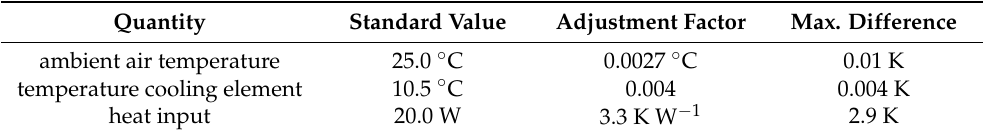
Table 3. Standard values, adjustment factors, and maximum temperature difference caused by a variation in the measured range for the varying parameters according to Equation (3).